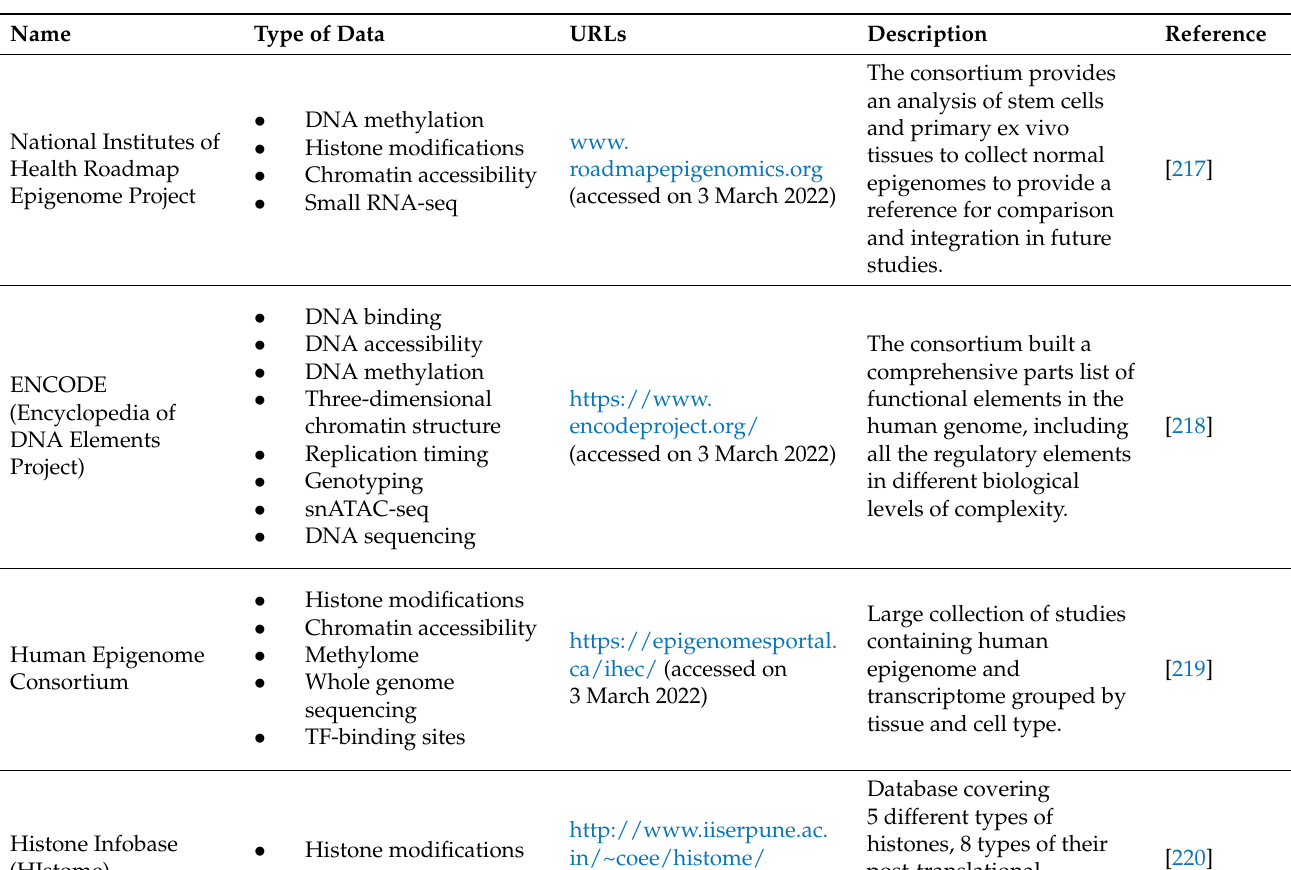
Table 2. Resources containing epigenic